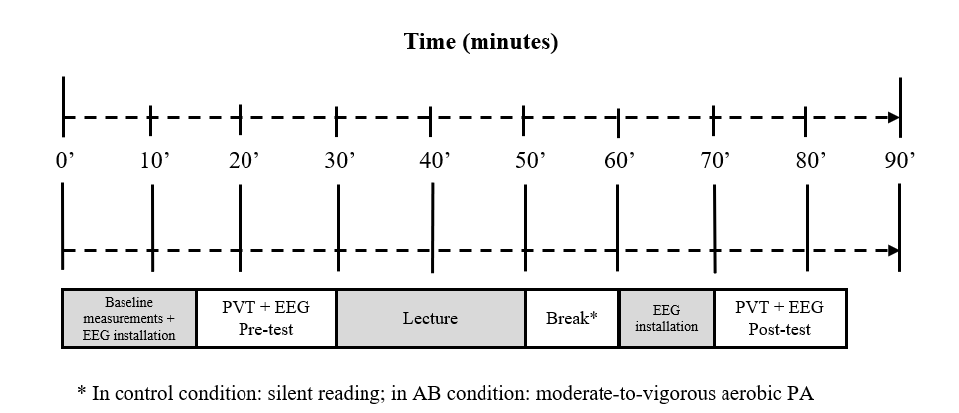
Figure 1. Schematic representation of experimental